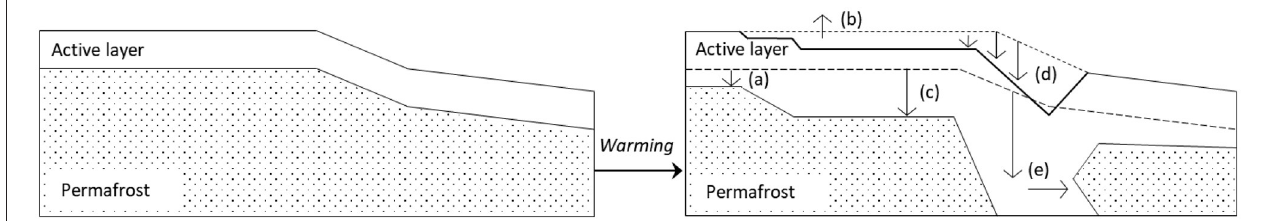
FIGURE 1 | Conceptual figure illustrating possible changes in permafrost environments due to ongoing climate change, including (a) active layer thickening; (b) combustion of soil organic matter during more frequent and severe fires; (c) accelerated active layer thickening following fire; (d) surface subsidence and development of abrupt thaw features, including in response to increased fire activity; (e) progressive, fire-induced thaw of the full permafrost table in more southerly regions of discontinuous permafrost, including through the formation and lateral expansion of